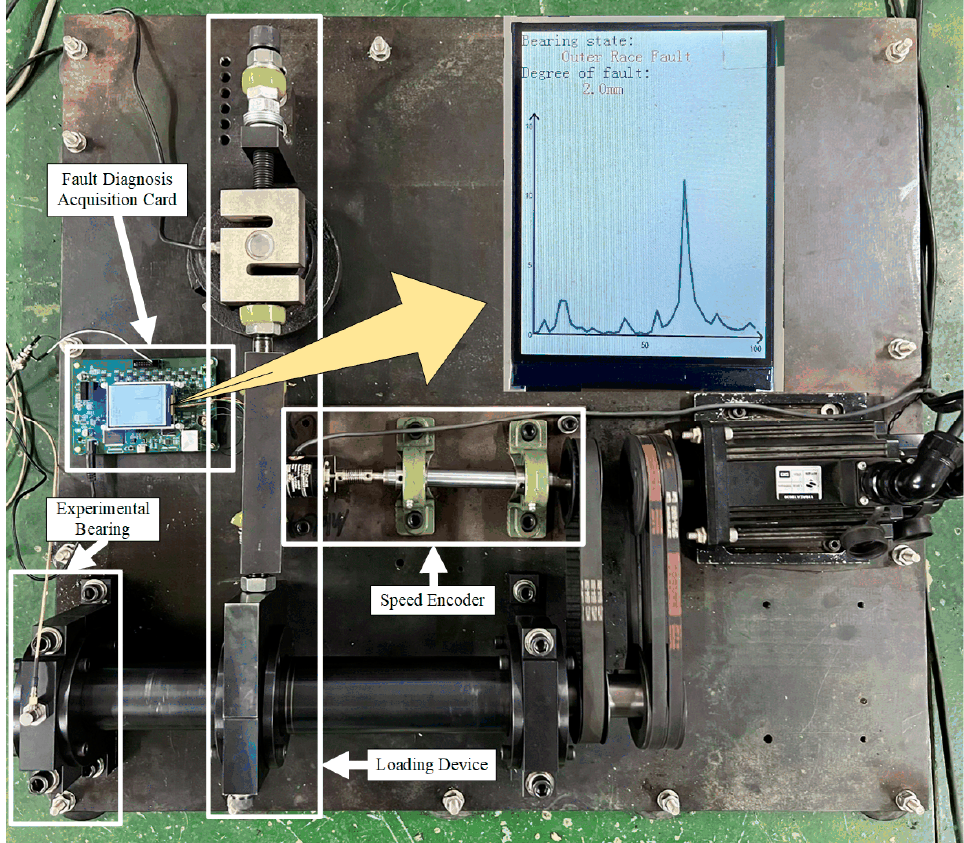
Figure 15. Offline fault diagnosis experimental device.